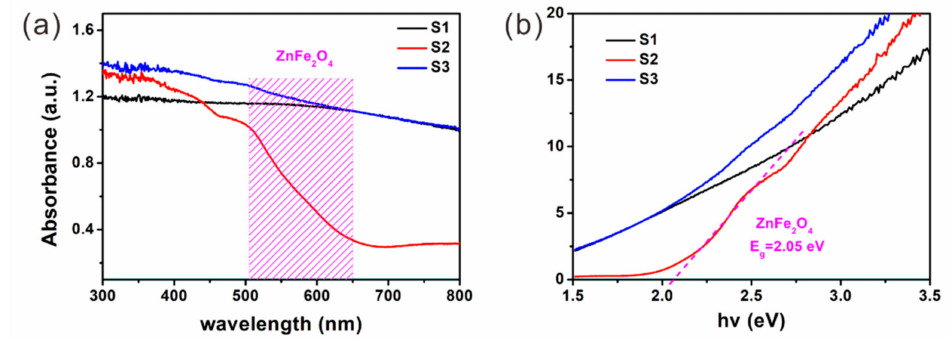
Figure 2. ( a ) UV-Vis diffuse reflectance spectra and ( b ) Tauc plot of S1–S3. For a better understanding of the defects-related emissions, Gaussian fitting of the spectra were conducted and displayed in Figure 3b–d. In terms of S1 (Figure 3b), the deconvoluted peaks at ~367 nm and ~387 nm is due to the band-to-band emission and near band-edge emission of ZnO, respectively. As reported by previous studies [34–36], the peak at ~440 nm is attributed to the transition between the Zn i level (located ~0.22 eV below the conduction band) to the V Zn level (located ~0.3 eV above the valance band). The emission peak at ~515 nm is widely recognized to be related to the electron–hole recombination between the conduction band and the V O level [37,38]. As analyzed above, the peak at ~625 nm should be the near band-edge emission of ZnFe 2 O 4 [39]. The last peak at ~732 nm may be generated by the deep-level defects in ZnO or ZnFe 2 O 4 . The Gaussian fitting result for S3 (Figure 3d) is similar to that of S1, with all the deconvoluted peaks appearing at similar positions. These deconvoluted peaks can also be obtained after a Gaussian fitting process to the spectrum of S2 (Figure 3c). Unlike S1 and S3, the V O -related emission of S2 is red-shifted to ~561 nm, which is due to the fact that the electron transitions occur between the Zn i level and the V O level rather than the conduction band and the V O level [40]. Moreover, S2 has one extra peak at ~682 nm, which should be due to the deep level